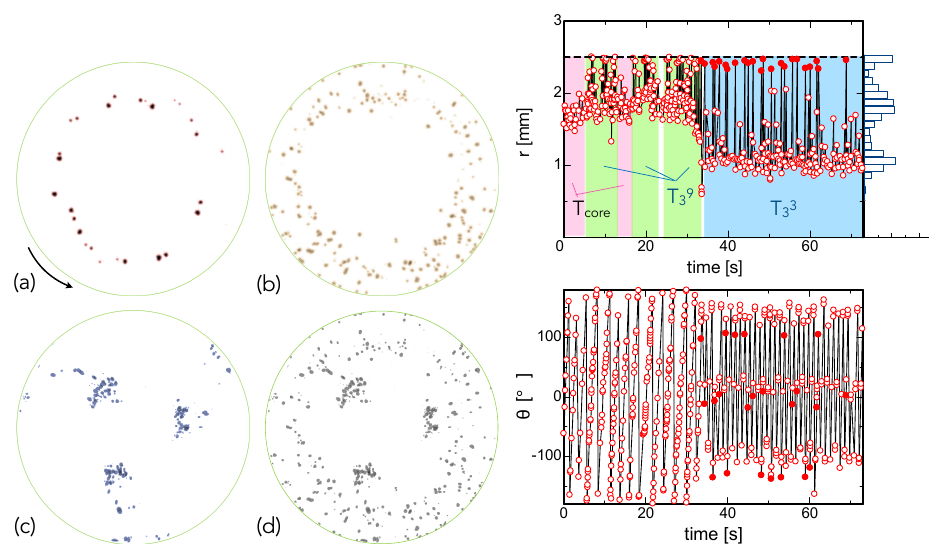
Figure 8. (left) Poincaré section at the midheight of the liquid bridge obtained by integrating ( a ) 0 ≤ t [ s ] ≤ 6.1, ( b ) 6.1 ≤ t ≤ 33.4, ( c ) 33.4 ≤ t ≤ 73.2 and ( d ) total images of the section for 73.2s detected at z = 0.81 ± 0.09 mm under Ma = 5.2 × 10 4 (same as row ( c ) in Figure 7 but in a different experimental run). (Middle) and (right) corresponding temporal variations of r - and θ -positions of a particle on the Poincaré section, respectively. The histogram on the right of the top graph illustrates the particle number density measured with a constant interval ∆ r = 0.1mm in the observation